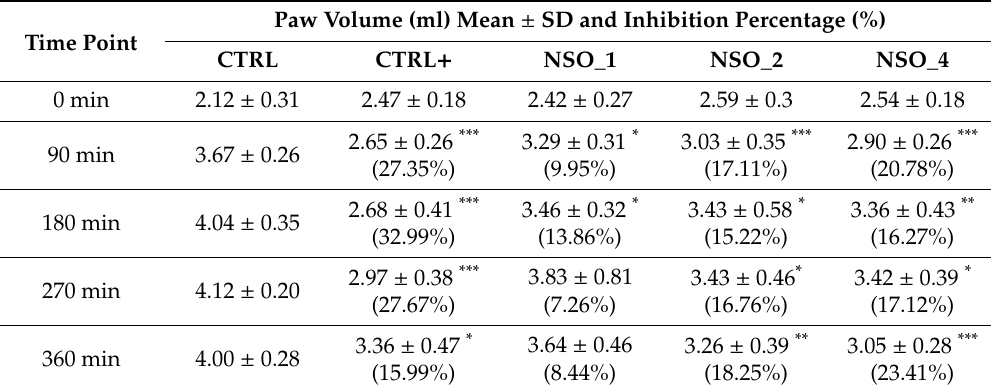
Table 4. The e ff ect of NSO on paw volume in the acute inflammation.